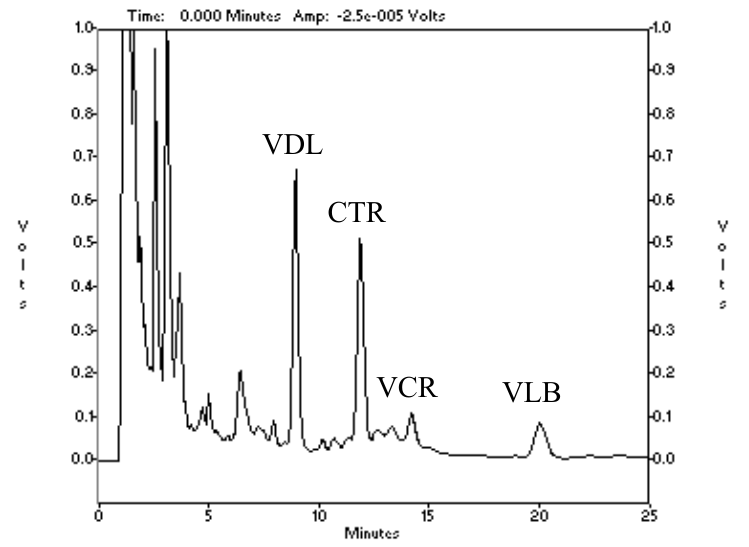
Figure 3. RP-HPLC trace of an extract of C. roseus monitored at 220 nm.